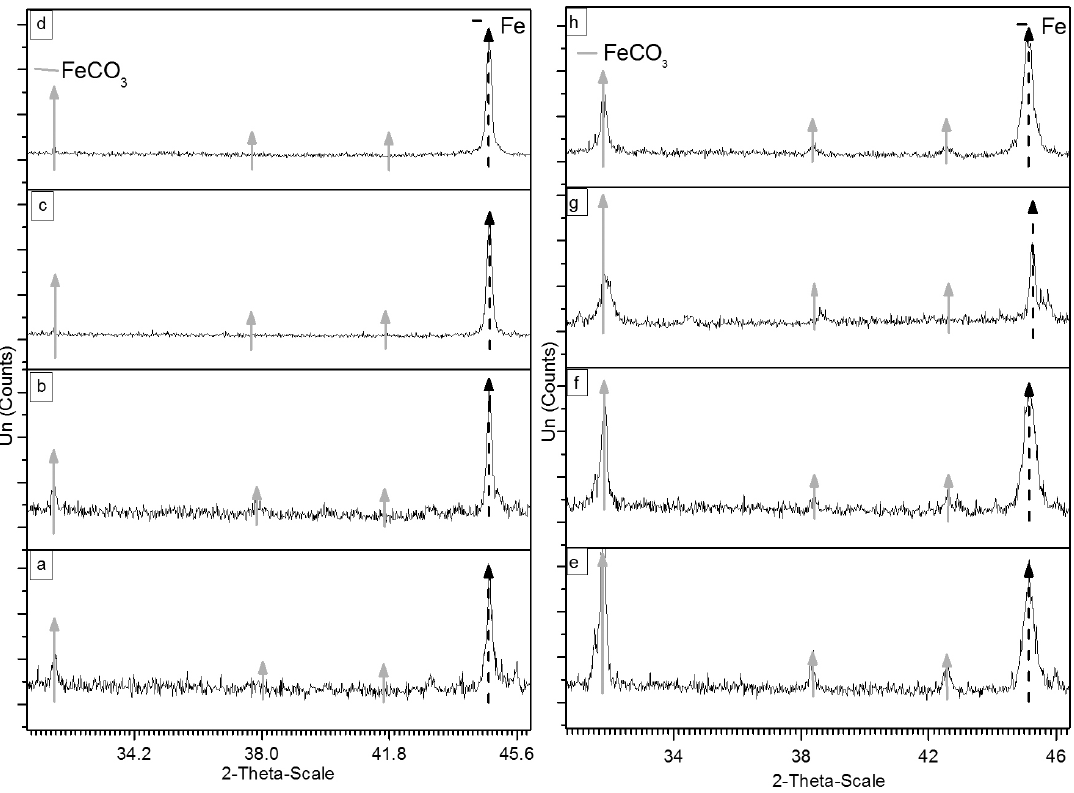
Figure 4. XRD patterns of the specimens immersed in the solution (I) at room temperature: (a) BMIX70, (b) WJIX70, (c) BMI X80, (d) WJIX80 and vapour phase (V) at 60 °C: (e) BMVX70, (f) WJVX70, (g) BMVX80, (h) WJV